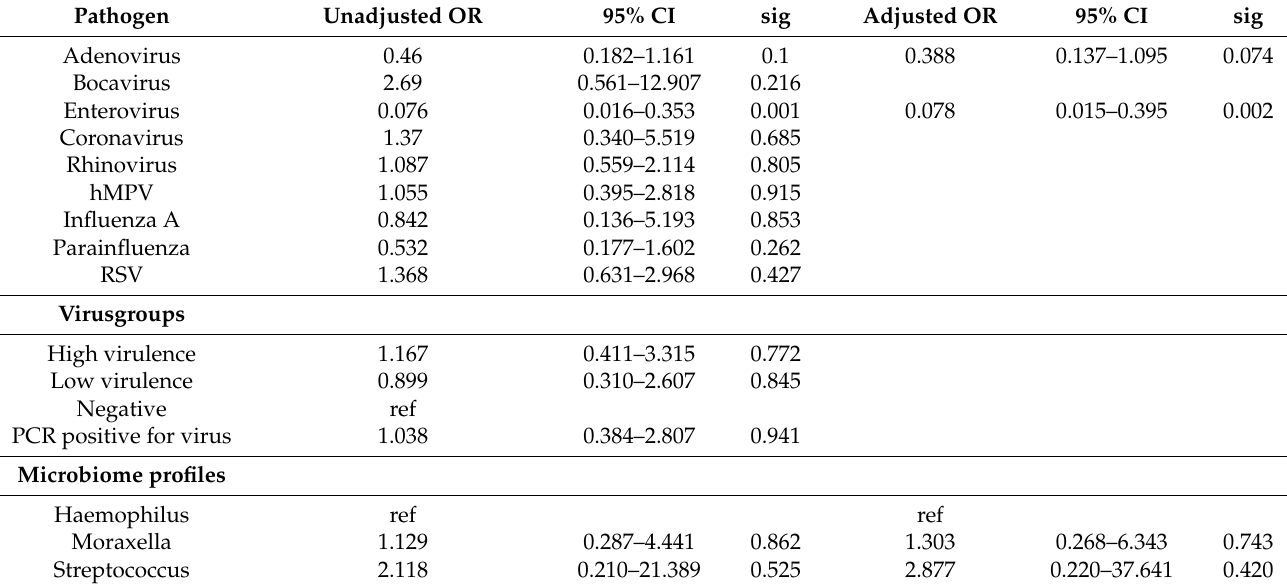
Table 3. Unadjusted and adjusted associations of viruses and microbiome profiles with